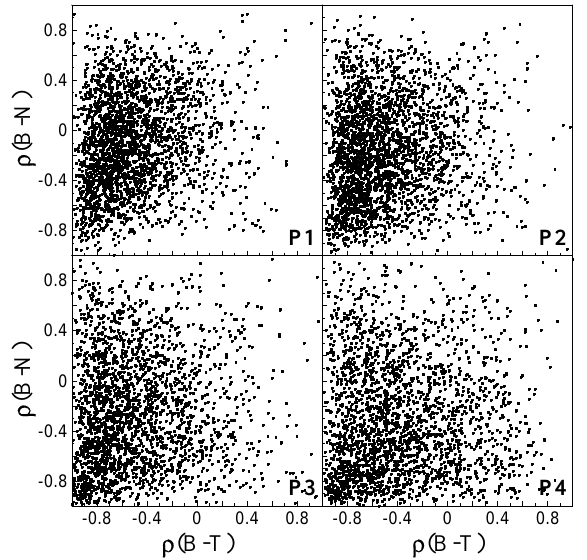
Fig. 5. The four panels show scatter plots of ρ ( N − P t ) vs. ρ(P m - P k ) for the four polar wind samples (P1 to P4).